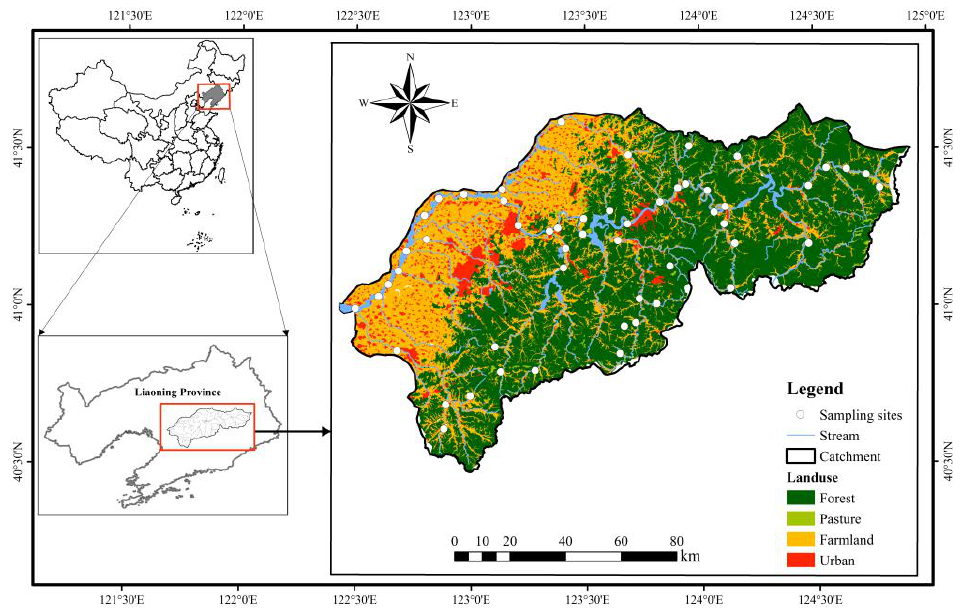
Figure 1. Map of sampling sites in the Taizi River Basin.